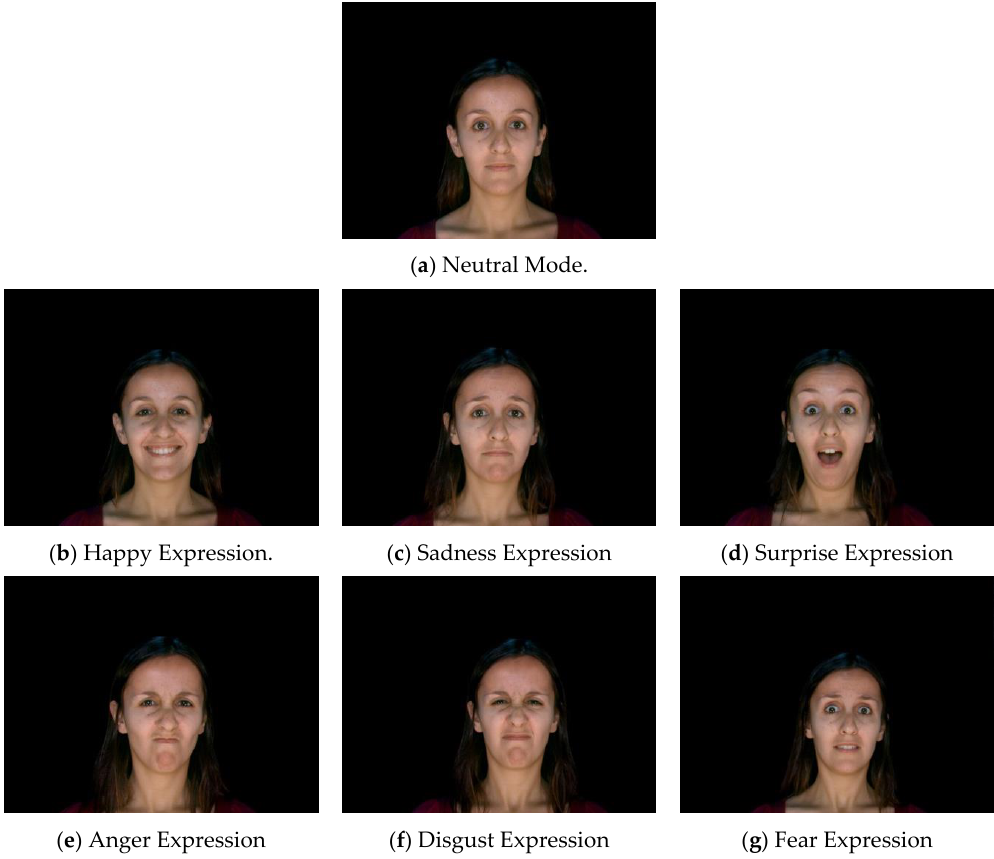
Figure 10. Subject 1 in IMPA-FACES3D [37] shows the following expressions: ( a ) neutral, ( b ) happy, ( c ) sadness, ( d ) surprise, ( e ) anger, ( f ) disgust, ( g ) fear [40].